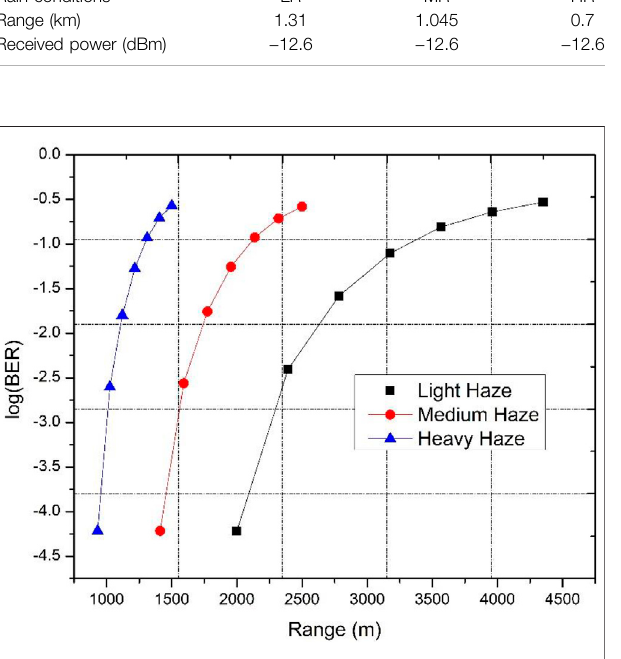
FIGURE 6 | log(BER) vs. range under various haze levels for OFDM/ SAC-OCDMA-FSO.